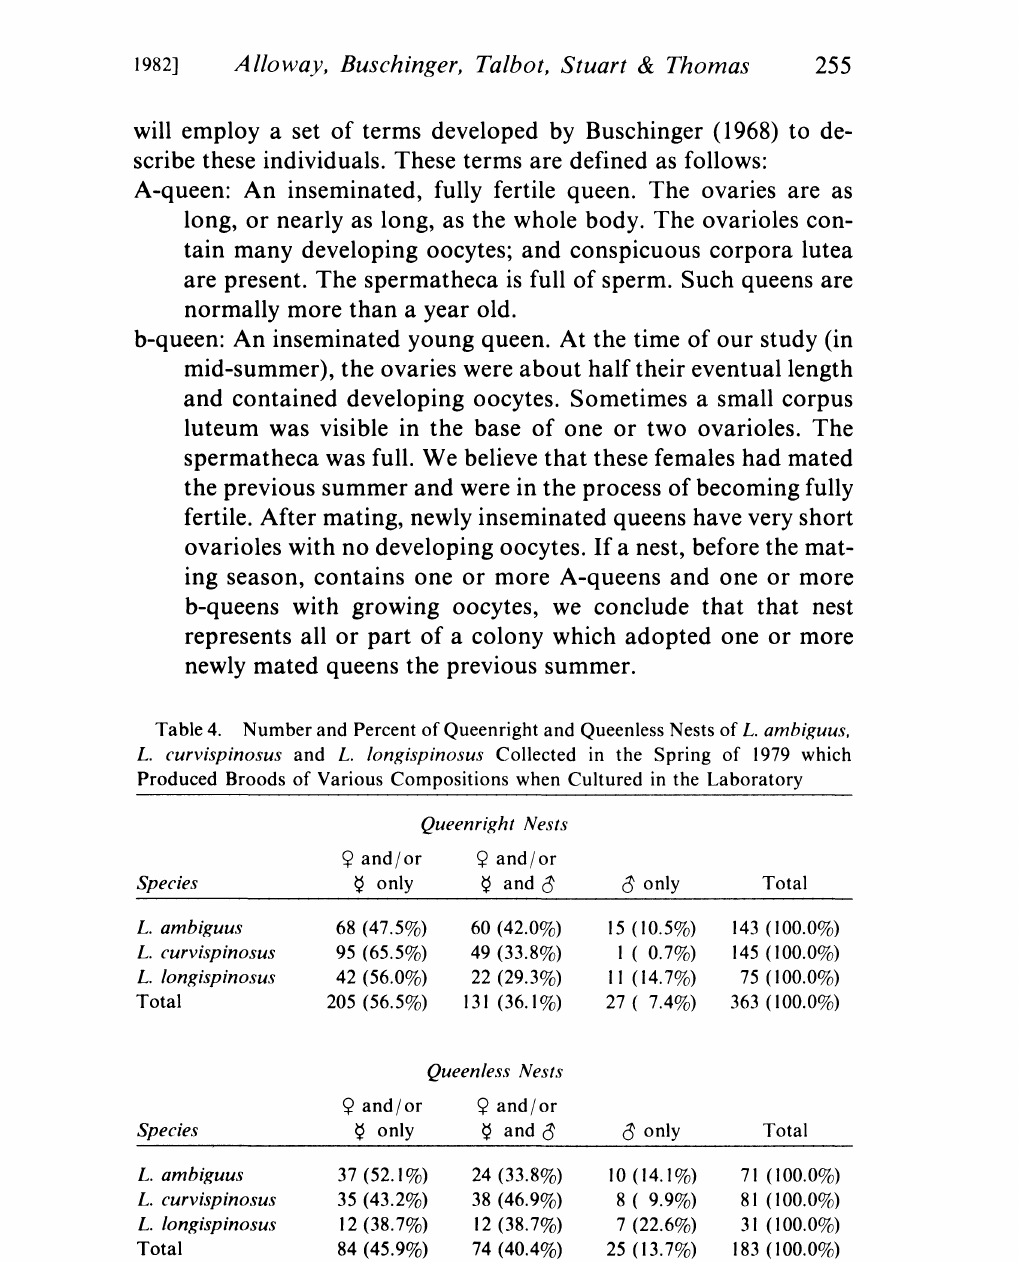
Queenless Nests and or ? and or Species only and only Total L.